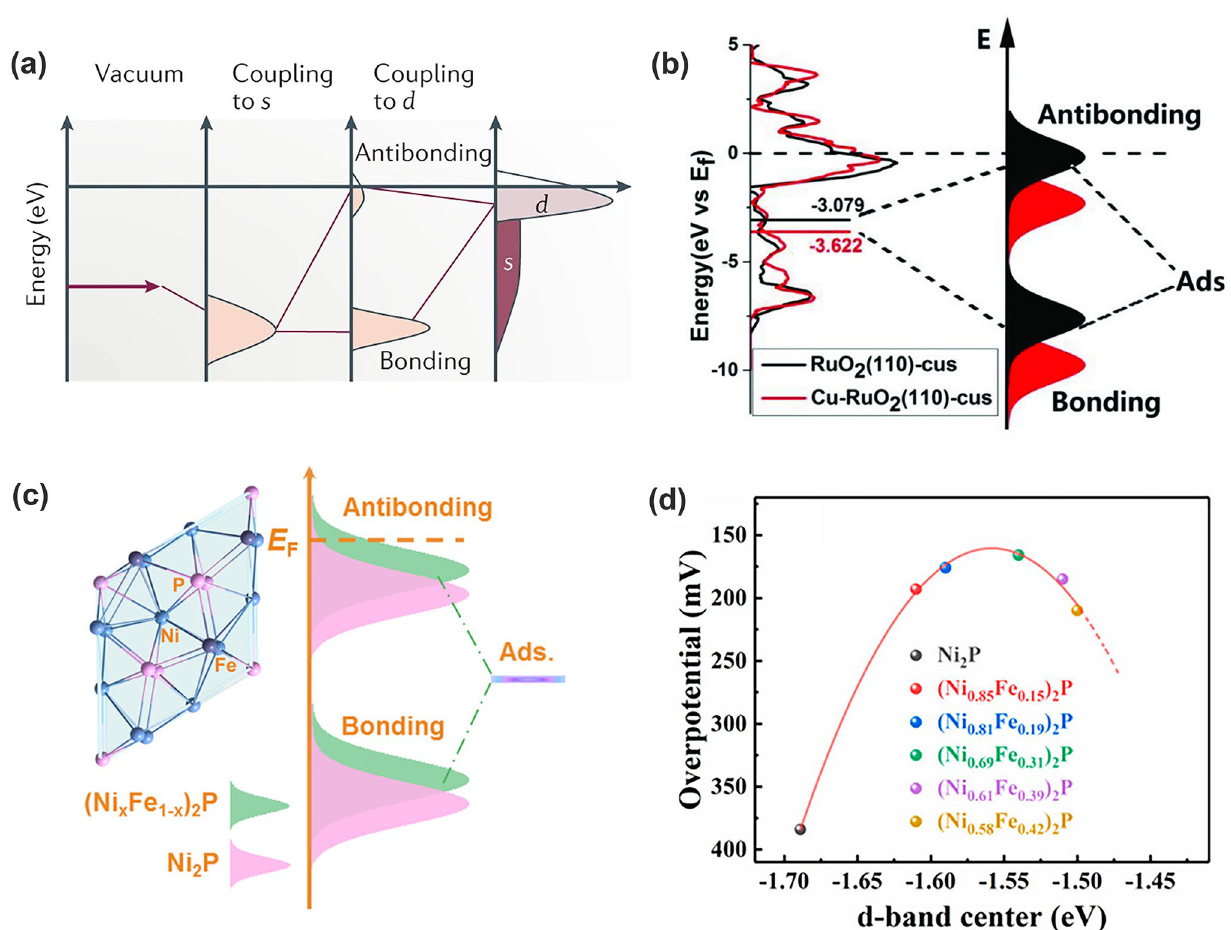
Fig. 4 a Schematic illustration of bond formation at a transition-metal surface. The lower the d states are in energy relative to the E F , the more filled the antibonding states and the weaker the adsorption bond [45]. Copyright © 2019 Springer Nature. b The density of states (DOS) plots of RuO 2 , Cu-RuO 2 , and the corresponding schematic illustration of bond formation between the reaction surface and adsorbate [49]. Copyright © 2018 Wiley–VCH. c d -band centers of Ni 2 P and Fe-doped Ni 2 P; d Relationships of the calculated d -band centers and experimental